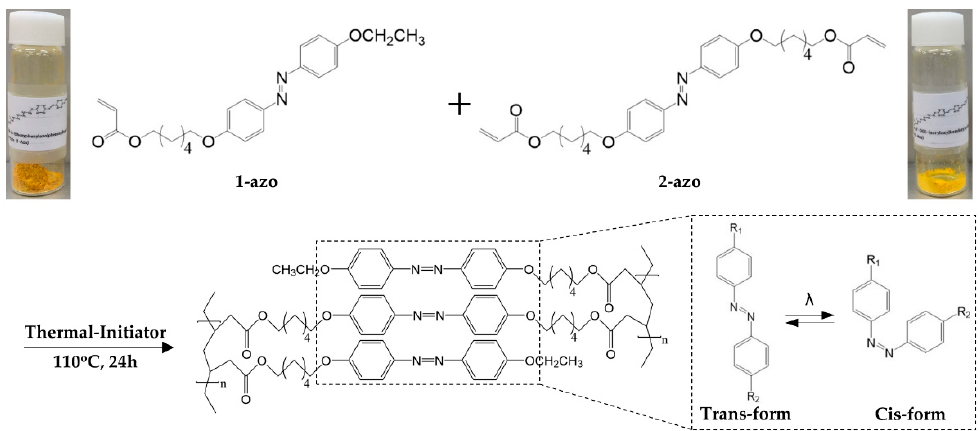
Figure 1. Chemical structures of the azobenzene liquid crystalline monomers (1-azo and 2-azo) used in this study and their polymerization schemes (the isomerization of the azobenzene group under ultraviolet light irradiation is indicated by the right dotted line).